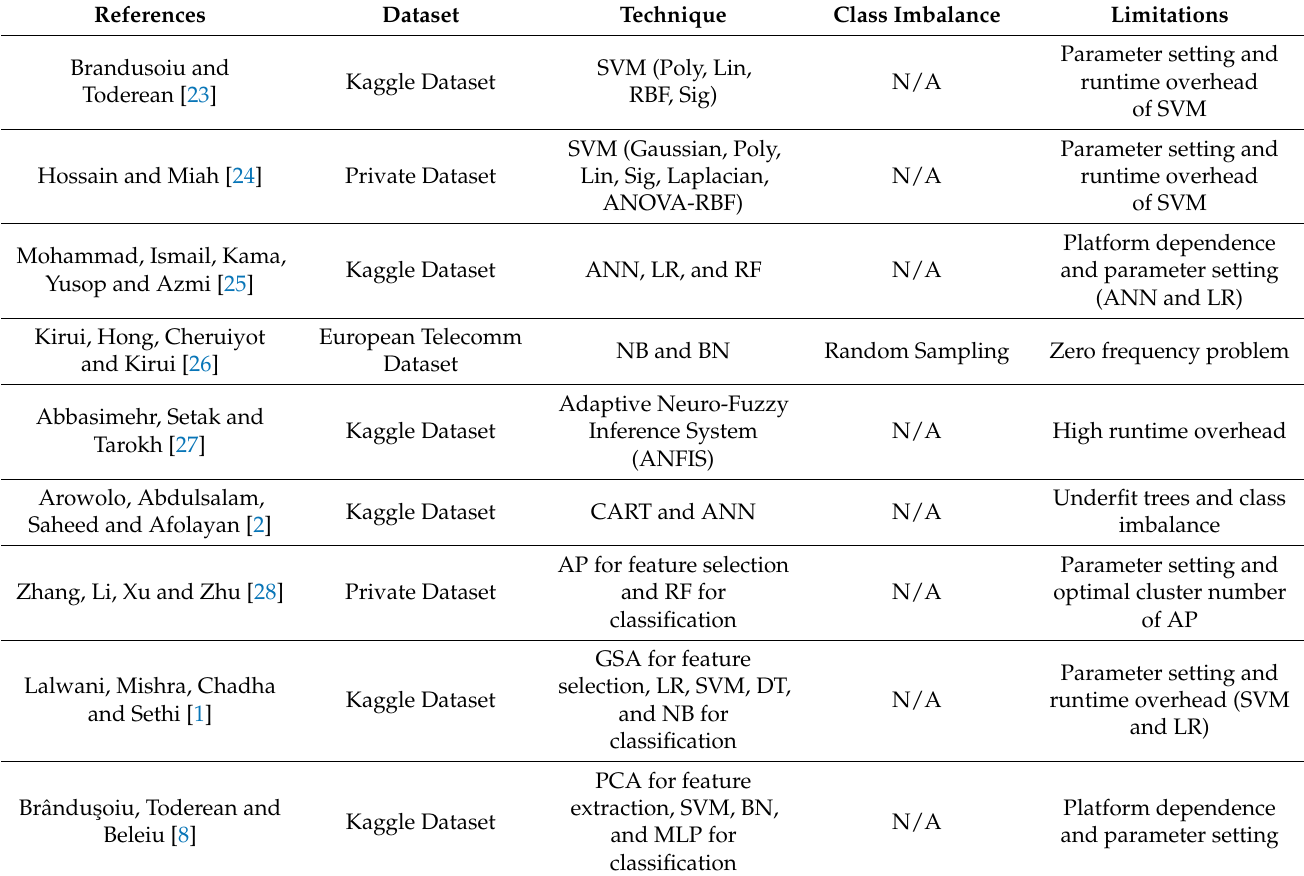
Table 1. An overview of notable current CCP